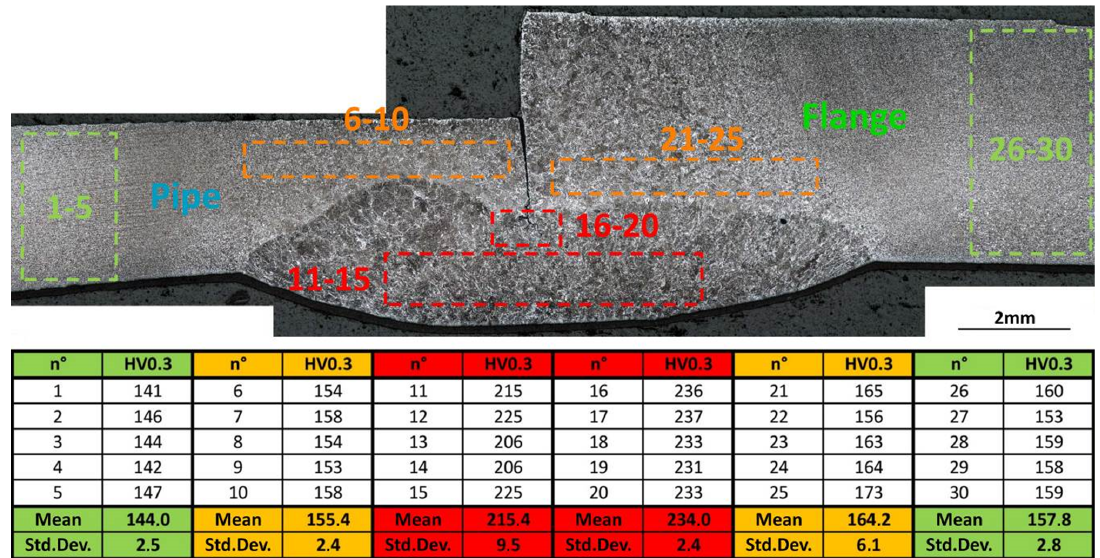
Figure 8. Metallographic analysis of one cracked region after etching using Nital 2% reagent. Bainitic microstructures characterize the heat-affected and melted zones. A branched crack is clearly visible at the crevice tip (MZ2). Table 2. Chemical analysis of two samples taken from the solution present inside the cooling Circuit n.2.